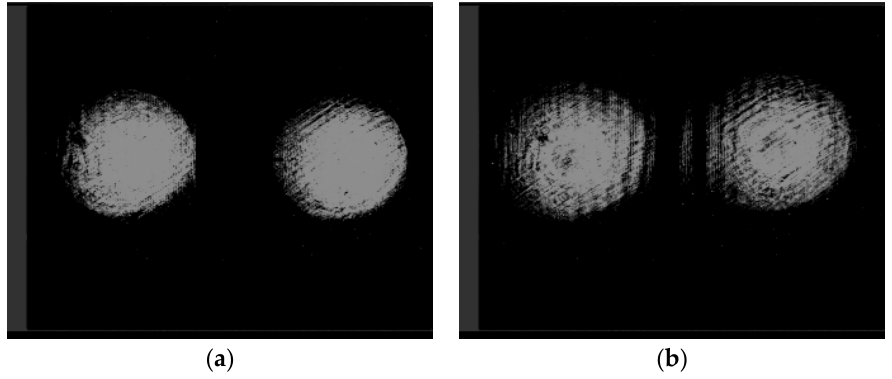
Figure 13. Intensity distributions in the diffraction orders after passing through lens L3 at a dis- tance of ( a ) 50 mm and ( b ) 100 mm. of ( a ) 50 mm and ( b ) 100